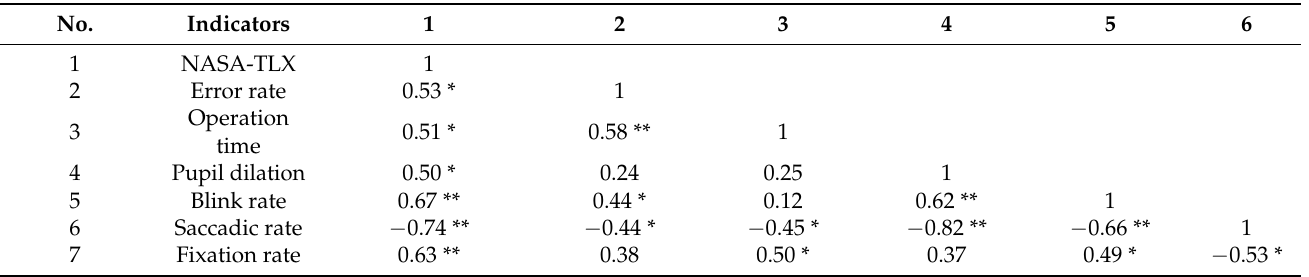
Table 9. Correlation analysis under the high